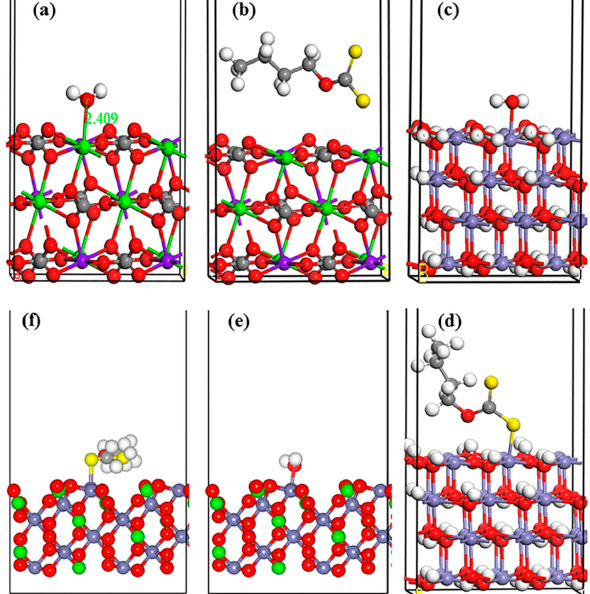
Figure 8. The most stable structures of water interact with the dolomite surface ( a ), xanthate reacts with the dolomite surface ( b ), water interacts with the Fe(OH) 2 surface ( c ), xanthate reacts with the Fe(OH) 2 surface ( d ), water interacts with the FeCO 3 surface ( e ), and xanthate reacts with the FeCO 3 surface ( f ). The O, C, H, Mg, Ca, and Fe atoms are represented as red, gray, white, purple, green, and lilac spheres, respectively.